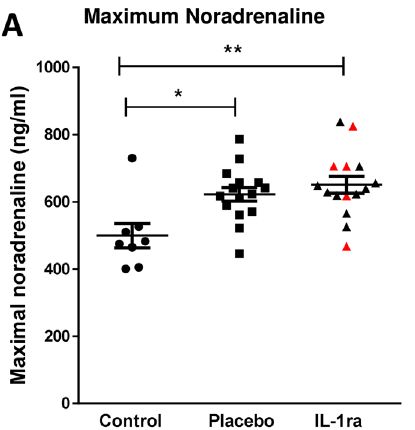
Figure 5. Plasma noradrenaline concentration is increased after stroke and is not affected by treatment with IL-1 receptor antagonist (IL-1Ra). Maximal noradrenaline concentration measured in the first seven days after stroke was significantly higher in both placebo and IL-1Ra treated patients in comparison to controls. Data show mean ± SD * P<0.05 ; ** P<0.01 ; one-way